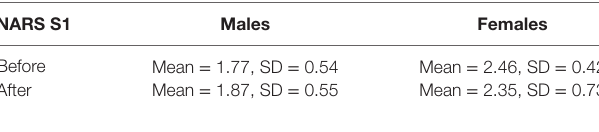
Table 5 | godspeed mean values (sD) compared between conditions. godspeed scale error